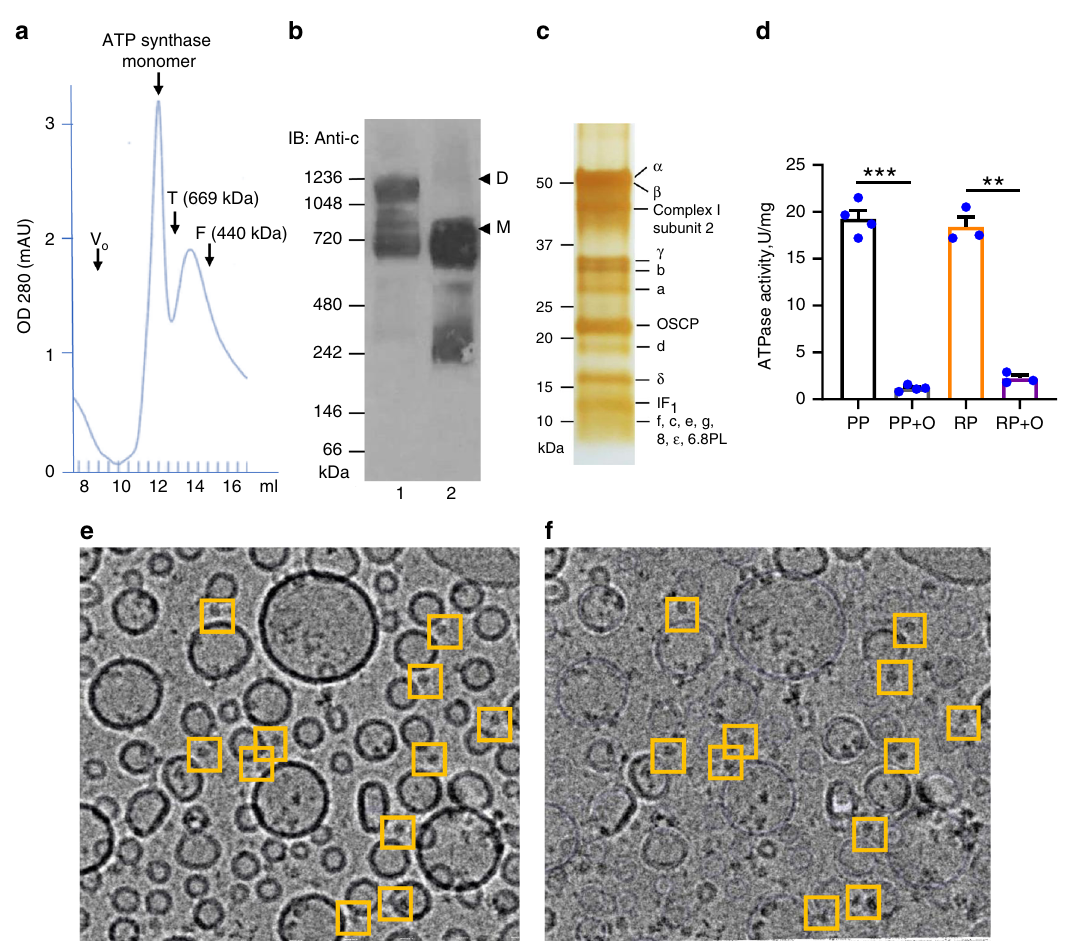
Fig. 1 DDM-puri fi ed ATP synthase forms monomers. a Size exclusion chromatography (SEC) pro fi le of puri fi ed ATP synthase monomer. A representative example of three independent runs is shown. Void volume of SEC column (V o ) and elution volume of protein molecular weight markers, thyroglobulin (T, 669 kDa) and ferritin (F, 440 kDa) are shown. b Blue-native PAGE and immunoblot analysis of porcine heart mitochondria solubilized with